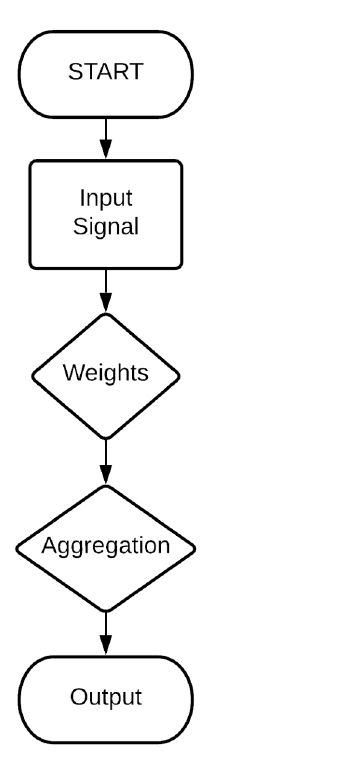
Figure 1. Flowchart of OWA Filter